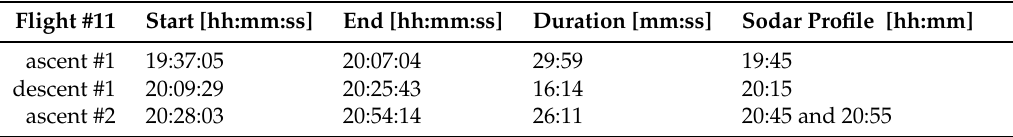
Table 1. Timestamps (UTC) and duration of the profiles of MASC-3 and the corresponding timestamp of the Sodar measurement for Flight